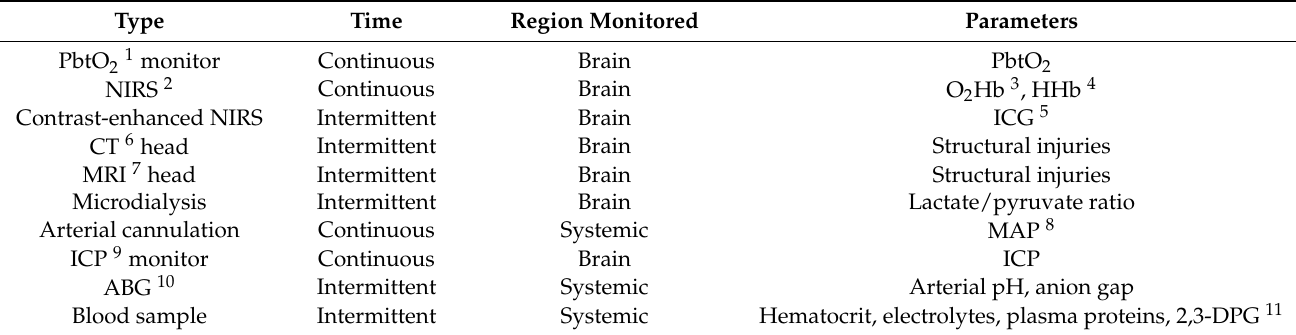
Table 1. Techniques for multimodal monitoring of brain tissue respiration in acute and subacute, moderate, and severe TBI